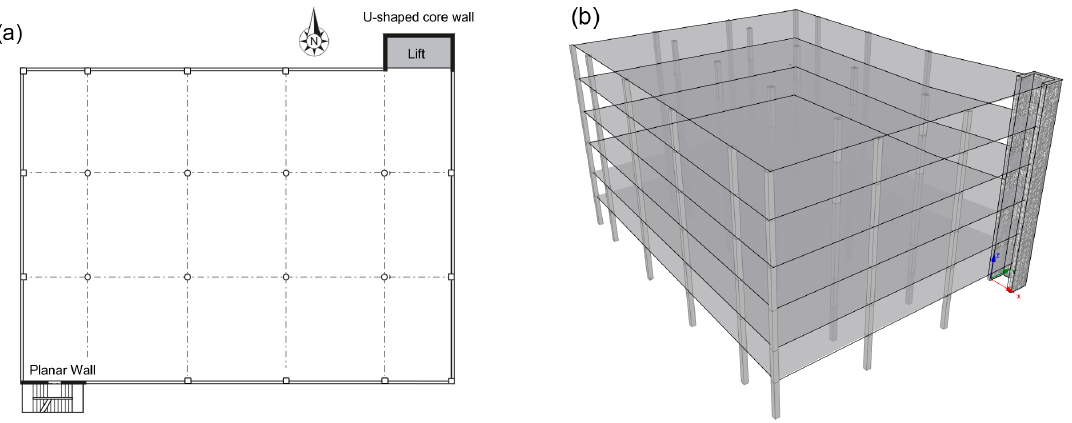
Figure 1. ( a ) Building plan with an RC U-shaped peripheral core wall ( b ) three-dimensional (3D) elevation view of an idealized six-story building with a single peripheral RC U-shaped core wall (adapted from SeismoStruct [12]; other structural members, such as beams, are not